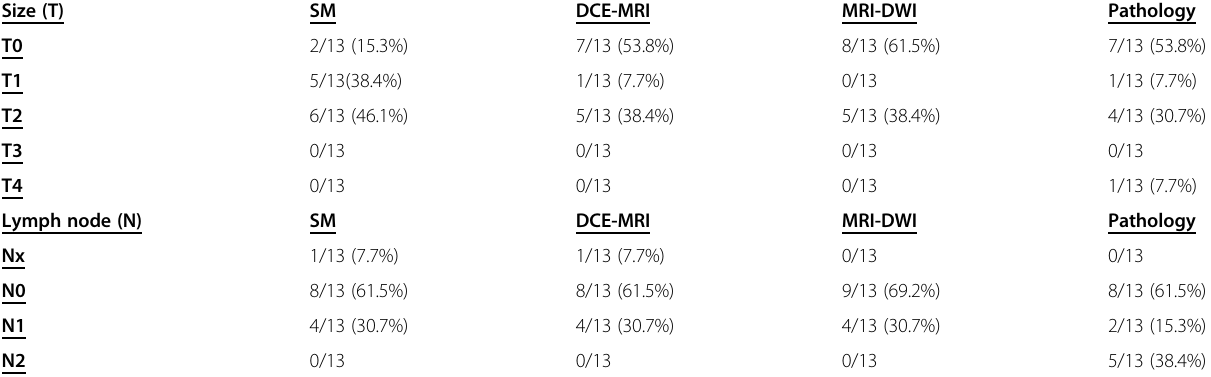
Table 7 Final T and N stages of the cases in the neoadjuvant group detected by different imaging modalities Size (T)